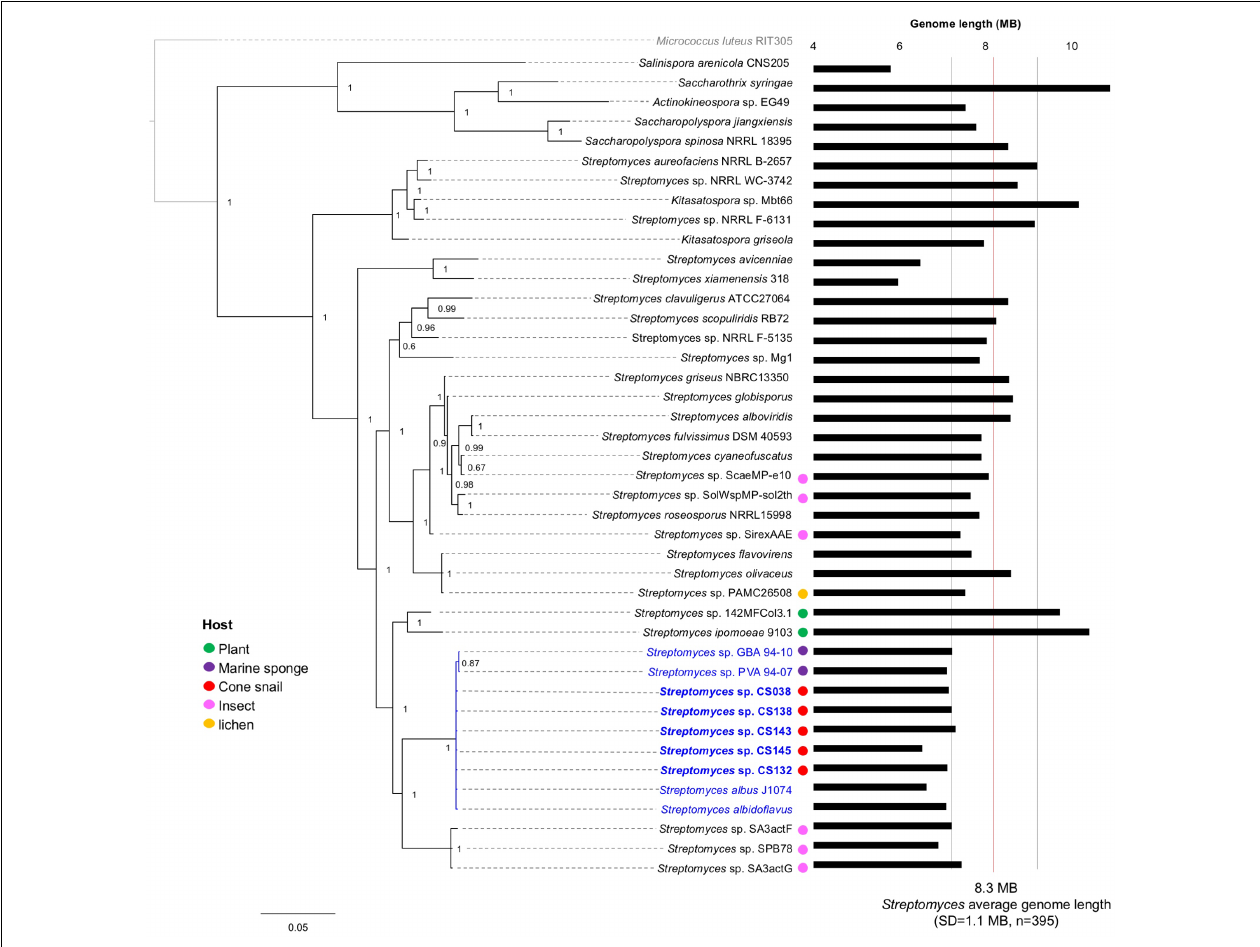
FIGURE 4 | Taxonomic relationships of Actinobacteria with PTM BGCs. The phylogeny was reconstructed using rpoB, and Micrococcus luteus was used as root. Posterior probability values are shown at the nodes. Organisms closely related to Streptomyces albus are highlighted in blue, including our Conus -associated strains (shown in bold letters). If reported, association with eukaryotic hosts is indicated with colored circles. The bars at the right represent the genome length for each taxon; a red line indicates the average genome length for Streptomyces species; and the flanking gray lines show its standard deviation. Accordingly, genomes smaller than 7.2 Mbp as those from insect-, sponge- and cone snail-associated streptomycetes are considered significantly reduced and genetically